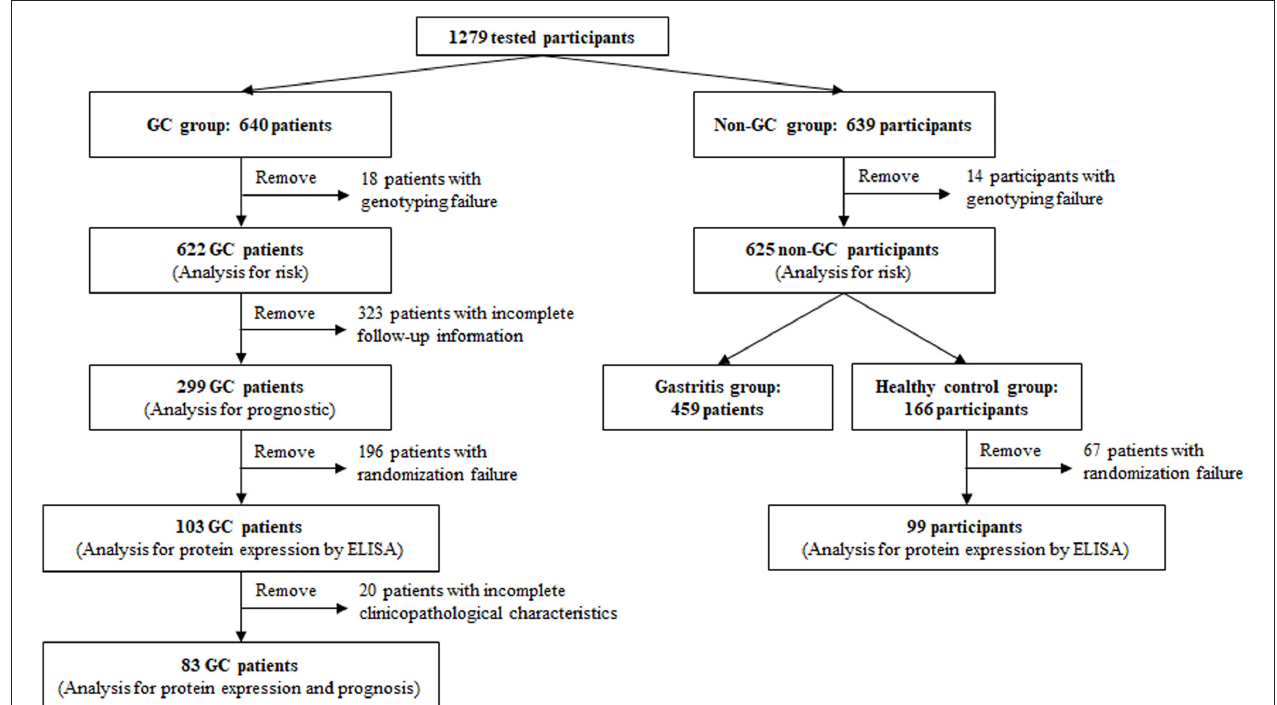
FIGURE 1 | Participants’ disposition. Human whole-blood genomic DNA tests were performed on 1,279 participants in this study, including 640 gastric cancer (GC) patients and 639 non-GC participants. Due to genotyping failure on some participants, the analysis of correlation between TNFAIP2 TagSNPs and GC risk was performed on 1,247 eligible participants, including 622 GC patients and 625 non-GC participants. Due to incomplete follow-up information, the analysis of correlation between TNFAIP2 TagSNPs and GC prognosis was performed on 299 GC patients. The analysis of TNFAIP2 protein expression and GC risk and prognosis was performed on 202 participants randomly selected from the GC group and the healthy control group, including 103 GC patients and 99 healthy persons. Due to incomplete clinicopathological characteristics, only 83 GC patients were enrolled in the analysis of correlation between serum TNFAIP2 protein expression and GC